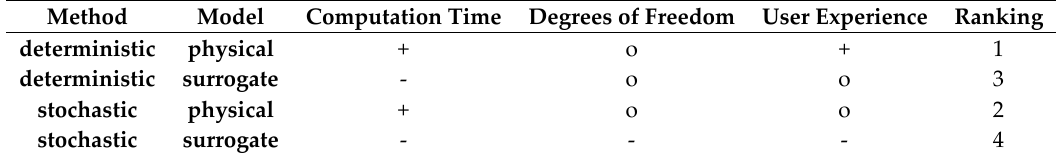
Table 1. Summary of the properties referring to the methods presented. The convention of the symbols is: “+” meaning lower computation time, higher degrees of freedom and less user experience. The inverse applies to “-“. Intermediate values are indicated with